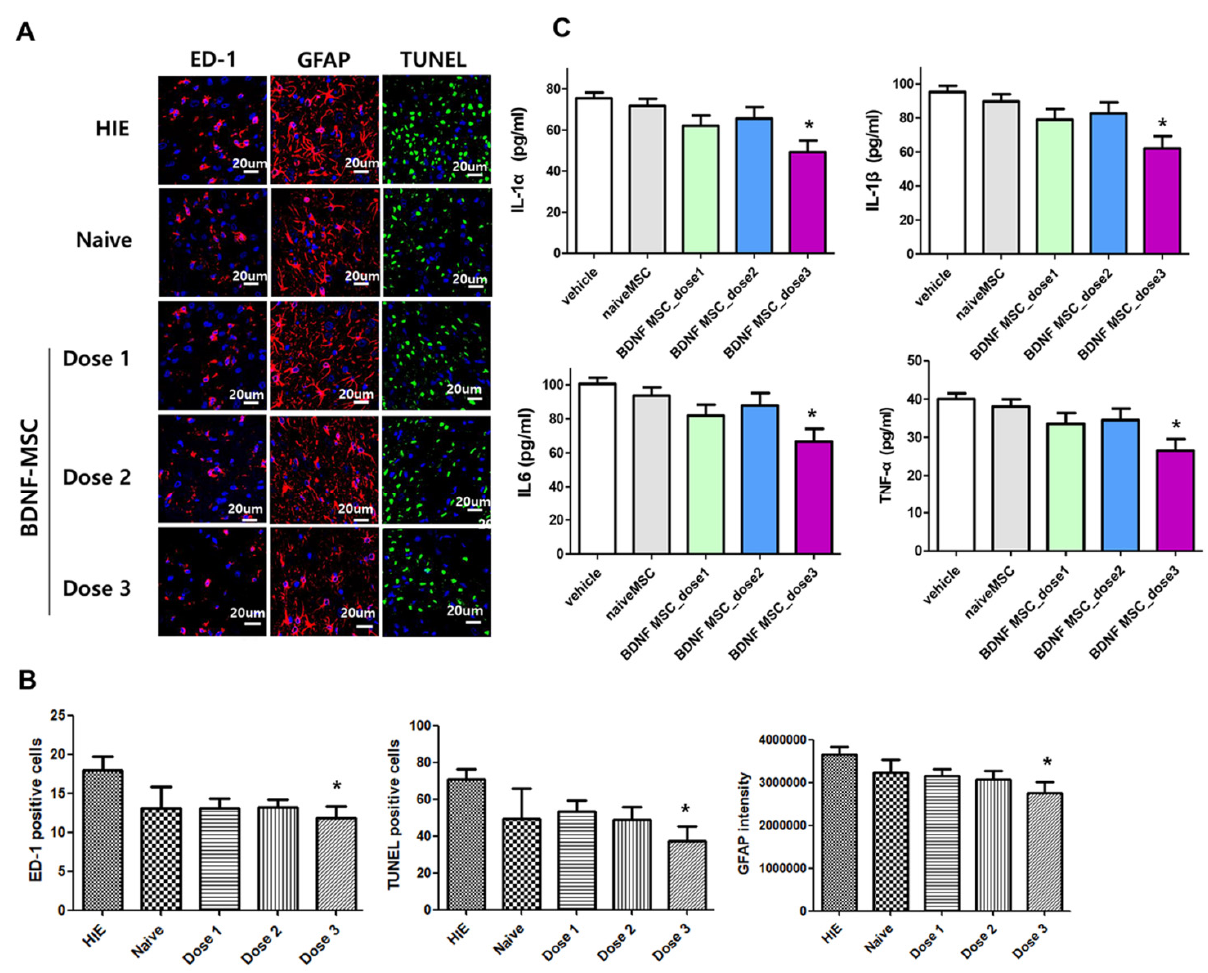
Figure 6. Brain tissue injury including inflammation, cell death, and reactive gliosis after hypoxic ischemic injury and MSC transplantation. ( A ) Representative immunofluorescence photomicrographs of the penumbra area with staining for ED1 (red), glial fibrillary acidic protein (GFAP) (red), TUNEL (green), and 4 ′ ,6-diamidino-2-pheylindole (DAPI) (blue) in the brains at 5 weeks after modeling. ( B ) The average number of ED1-positive cells, TUNEL-positive cells, and mean light intensity of GFAP, DCX, and MBP immunofluorescence per high-power field (HPF) in each group. ( C ) Levels of inflammatory cytokines including IL-1 α , IL- β , and IL-6 and TNF- α in total brain tissue homogenates at 5 weeks after modeling. Data are expressed as mean ± standard error of the mean. * p < 0.05 compared to the HI + vehicle control. Abbreviations: vehicle, HI + vehicle control, naïve MSCs; HI + naïve MSCs, BDNF MSC_dose1; HI + BDNF-eMSCs at 1 × 10 4 cells dose; BDNF MSC_dose2; HI + BDNF-eMSCs at 5 × 10 4 cells dose; BDNF MSC_dose3; HI + BDNF-eMSCs at 1 × 10 5 cells dose.